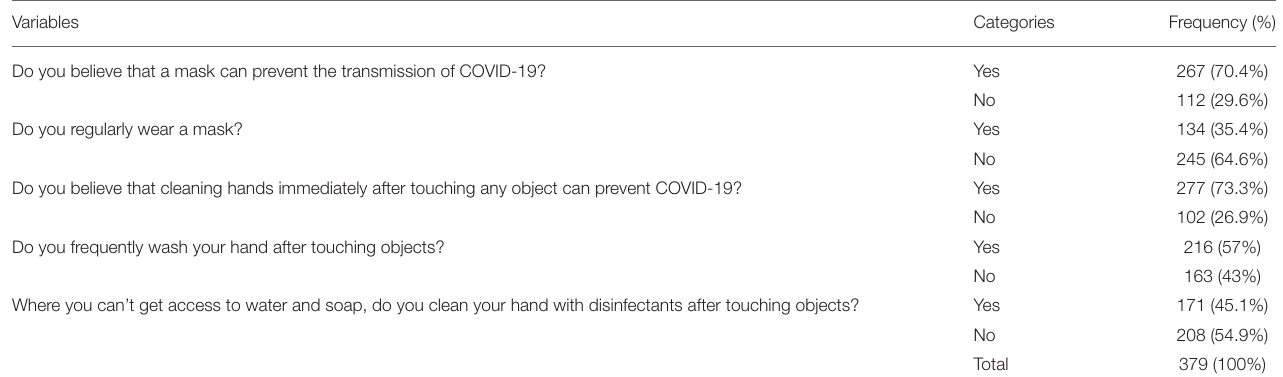
TABLE 2 | Distribution of compliance to personal protective behavioral recommendations.